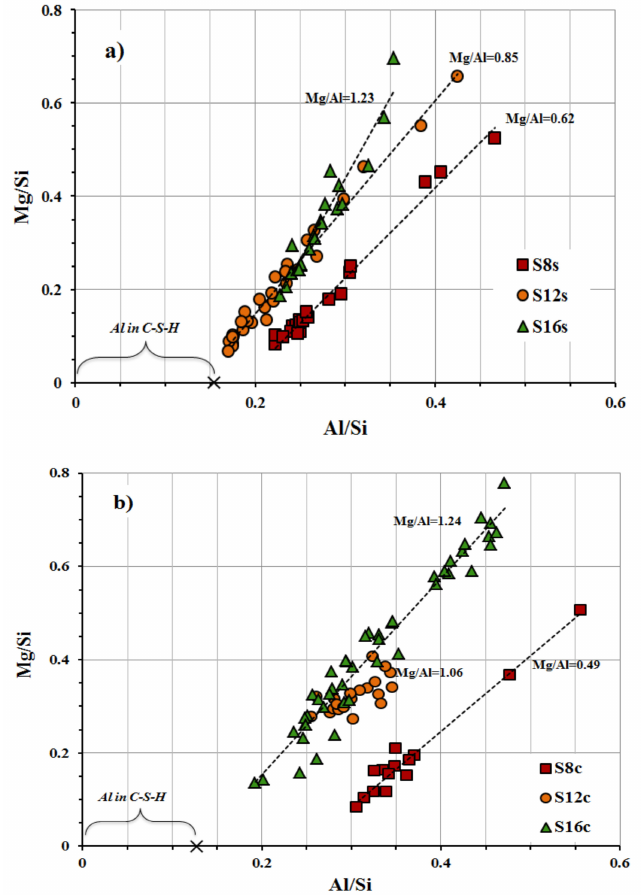
Figure 10. EDX analysis results after 28-day show the e ff ect of the atomic ratio Al / Si versus Mg / Si of the di ff erent slags activated with ( a ) 10% sodium silicate SS and ( b ) 10% sodium carbonate